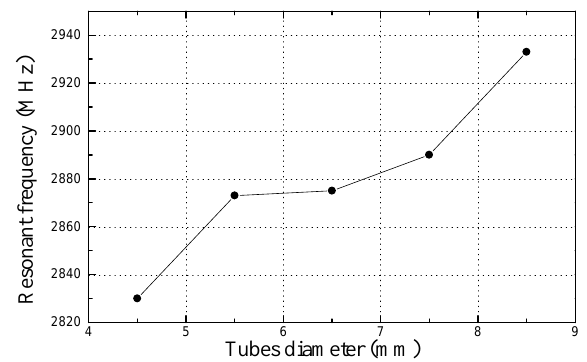
FIG. 3. Resonant frequency perturbation with supporting/ cooling tube diameter.